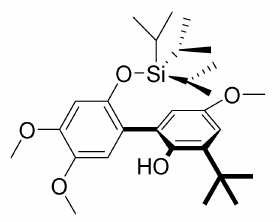
Figure 2. Molecular structure displaying the twist generated by TIPS.